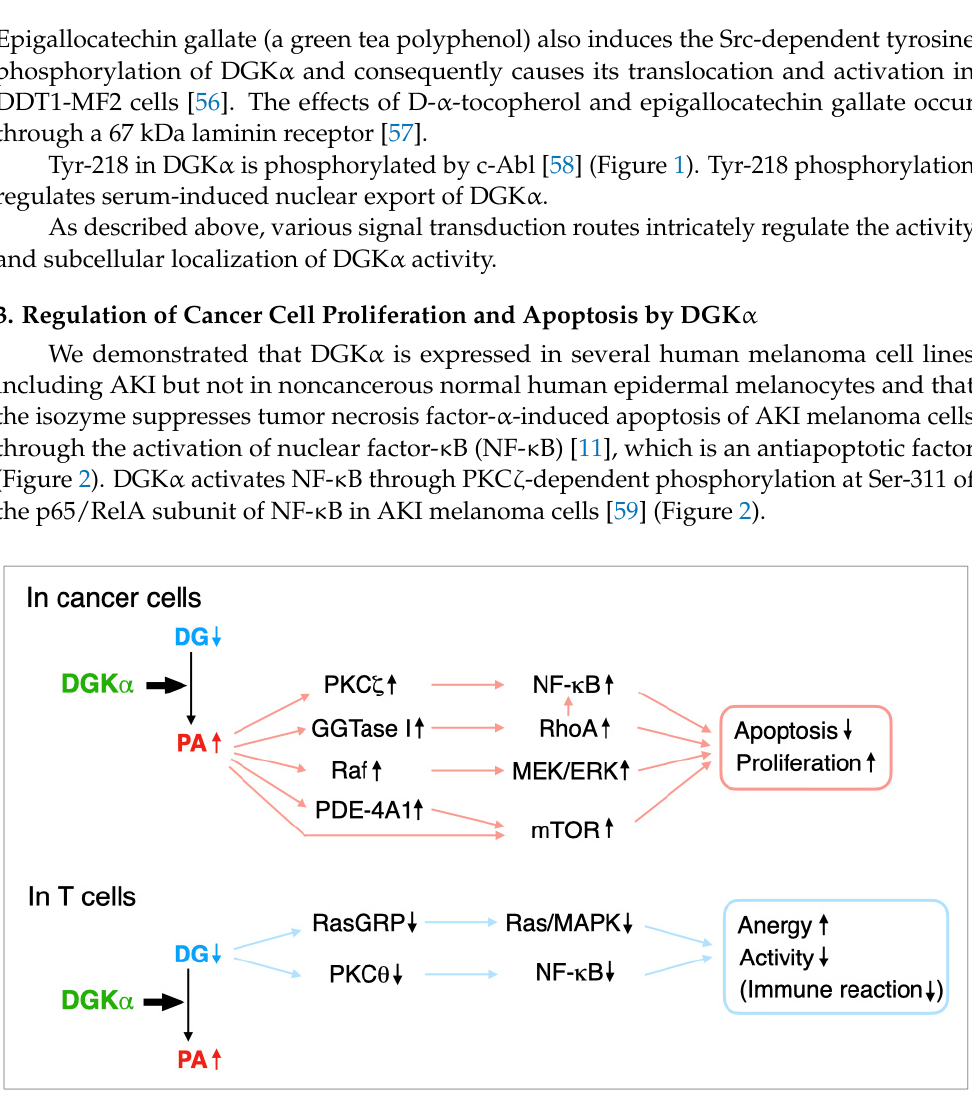
Figure 2. Proposed pathways utilized by DGK α in cancer cells and T lymphocytes. In cancer cells, DGK α acts as an antiapoptosis/proproliferation factor via the PKC ζ –NF- κ B, GGTase